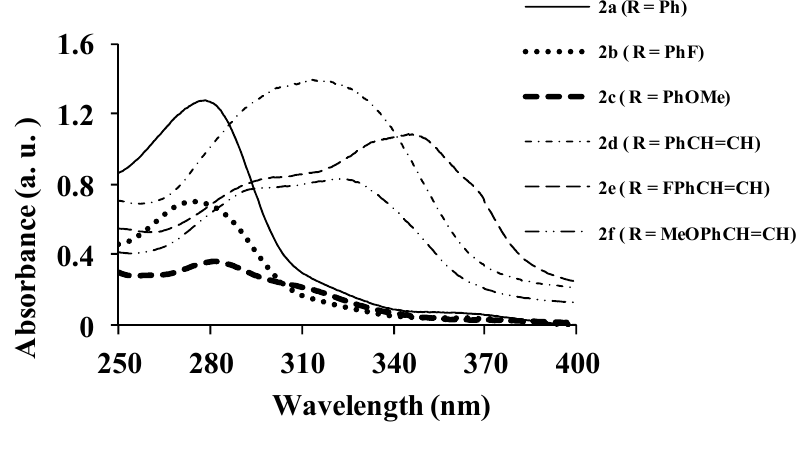
(conc. 2.0 × 10 − 7 3